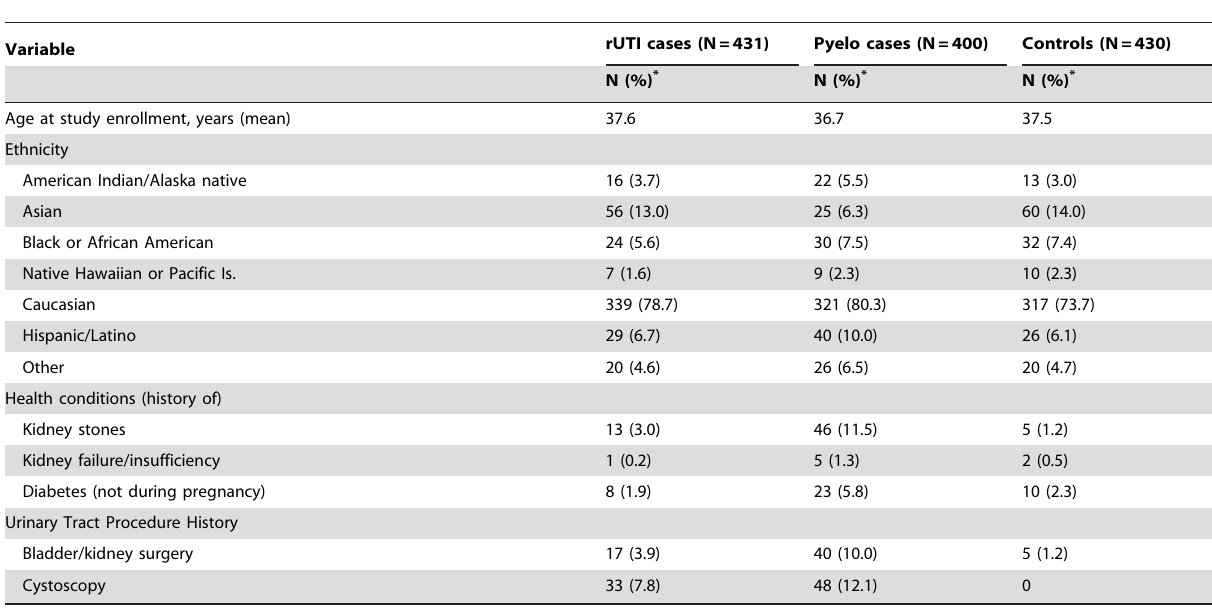
Table 1. Characteristics of Cases and